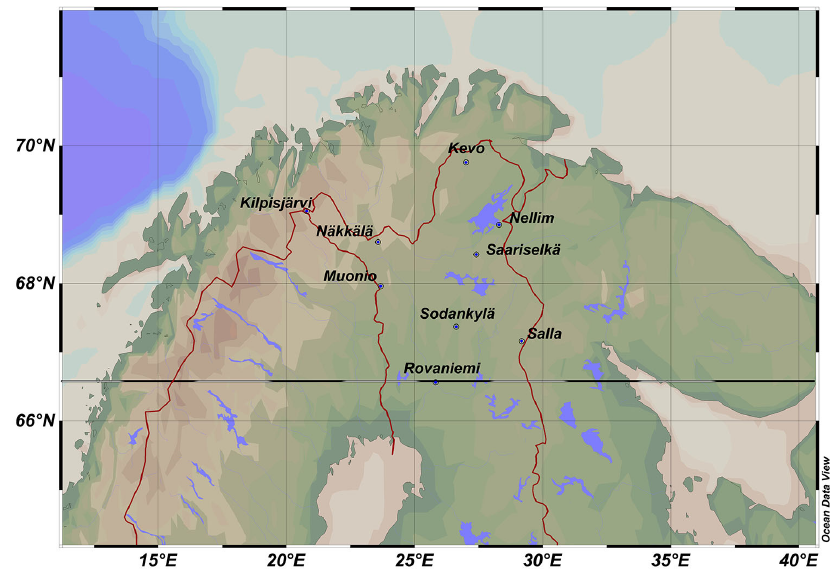
Fig. 1. The locations of the selected weather stations in Lapland (source: Ocean Data View 4). The dashed line represents the Arctic